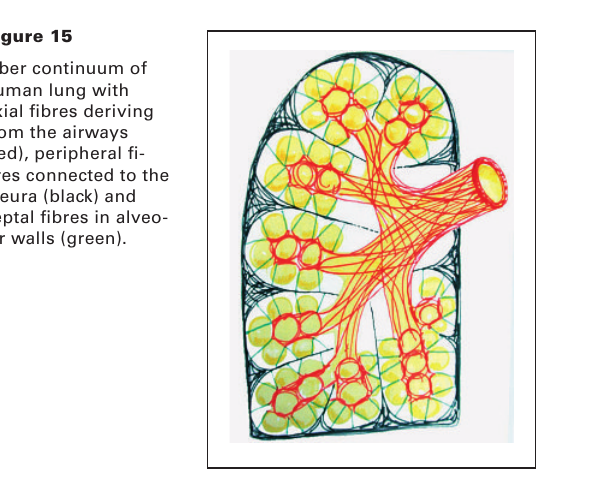
Fiber continuum of human lung with axial fibres deriving from the airways (red), peripheral fi- bres connected to the pleura (black) and septal fibres in alveo- lar walls (green).